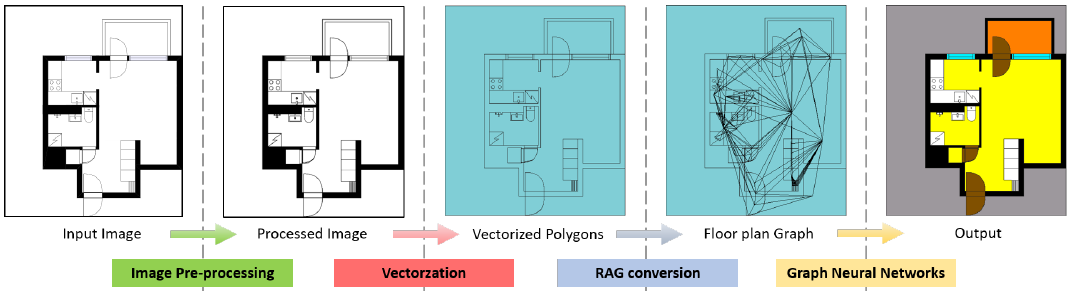
Figure 1. Overview of the proposed framework. The input floor plan image is pre-processed to erase texts and get binarized. The processed image is then vectorized depending on its closed regions and converted to an RAG. The floor plan graph is input to a GNN module in order to classify each polygon according to its and the neighbors’ feature